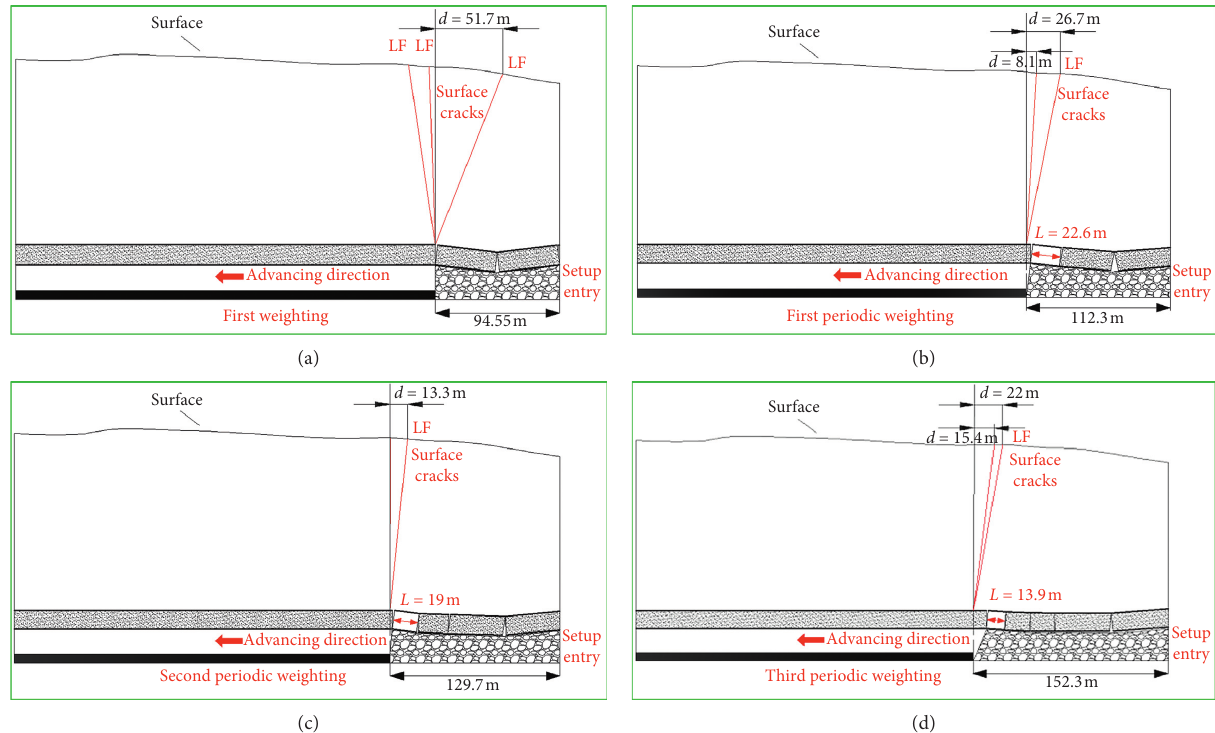
Figure 7: Contrast of broken blocks in key strata with surface-fractured wells. (a) The first weighting stage of working face, (b) the first periodic weighting stage, (c) the second periodic weighting stage, and (d) the third periodic weighting stage.